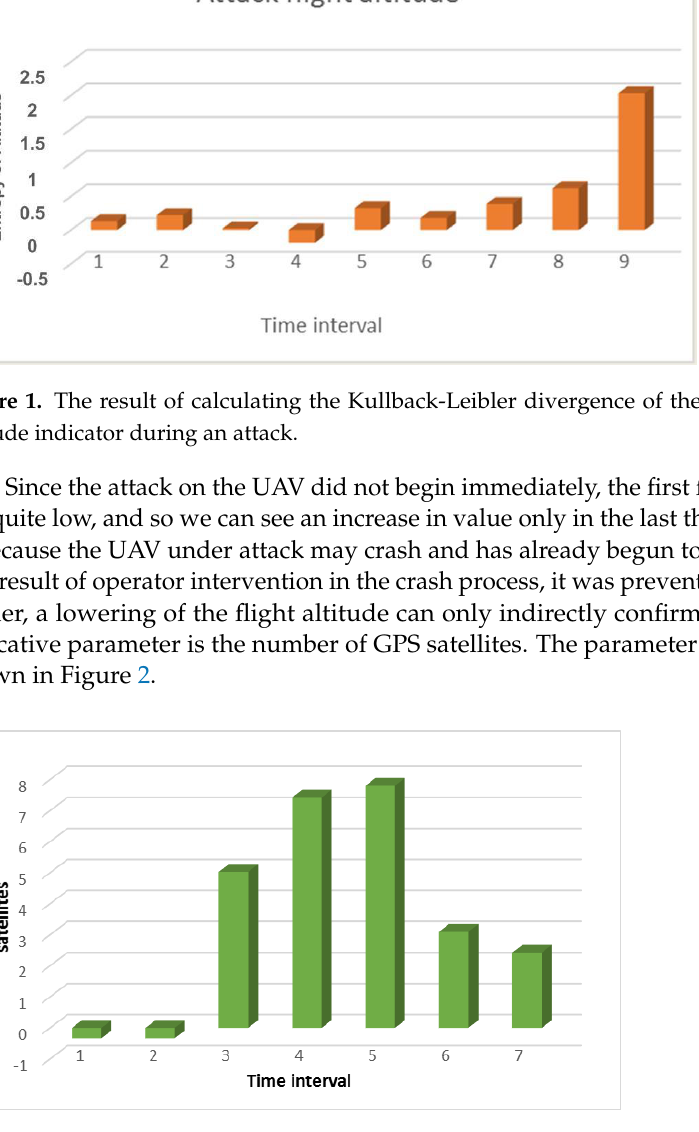
Figure 2. The result of calculating the Kullback-Leibler divergence for the indicator “number of GPS satellites” at the time of the attack.